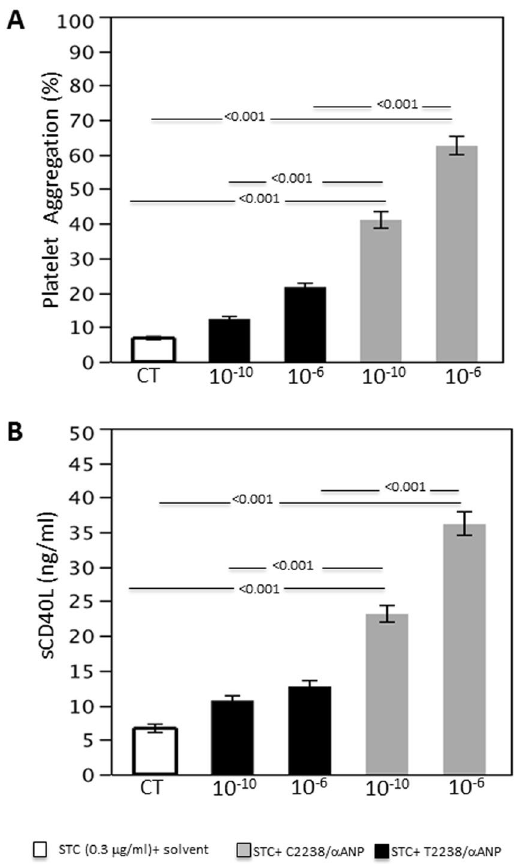
Figure 1. C2238/ α ANP induces platelet activation. ( A,B ) Platelets were incubated without the peptide or with either T2238/ α ANP or C2238/ α ANP at the specified concentration (10 − 6 M or 10 − 10 M) and the platelet activation was triggered by a sub-threshold concentration of collagen (0.3 µ g/ml). Platelet aggregation ( A ) and the concentration of the soluble CD40 ligand released by platelets ( B ) were assessed. N = 12. The results were expressed as mean ± SEM. In all the groups, a similar volume of solvent was